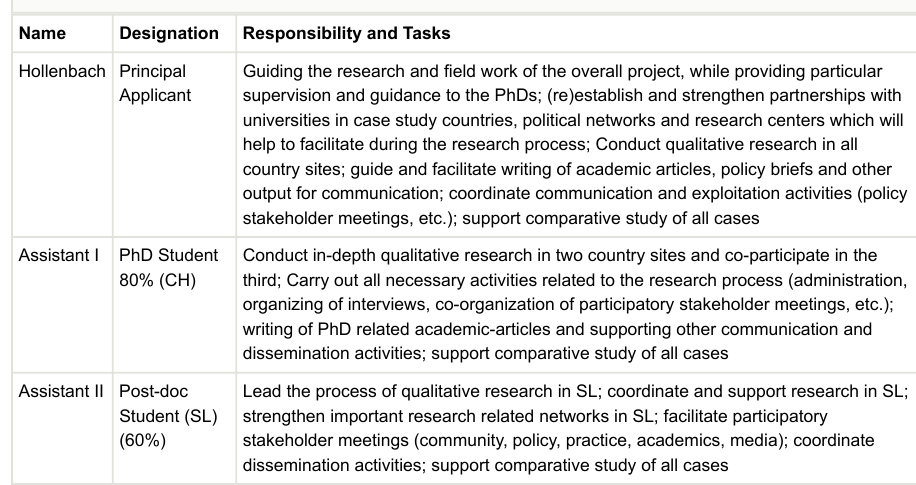
Works distribution and